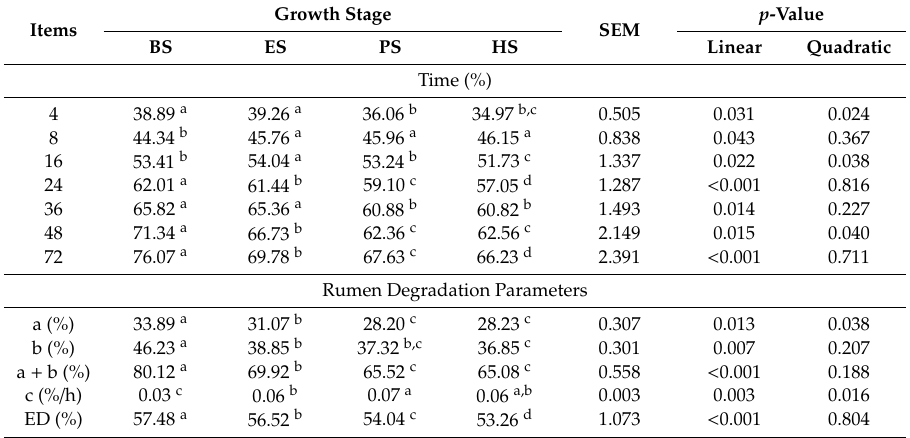
Table 2. Rumen degradability and degradation parameters of DM of amaranth silage.